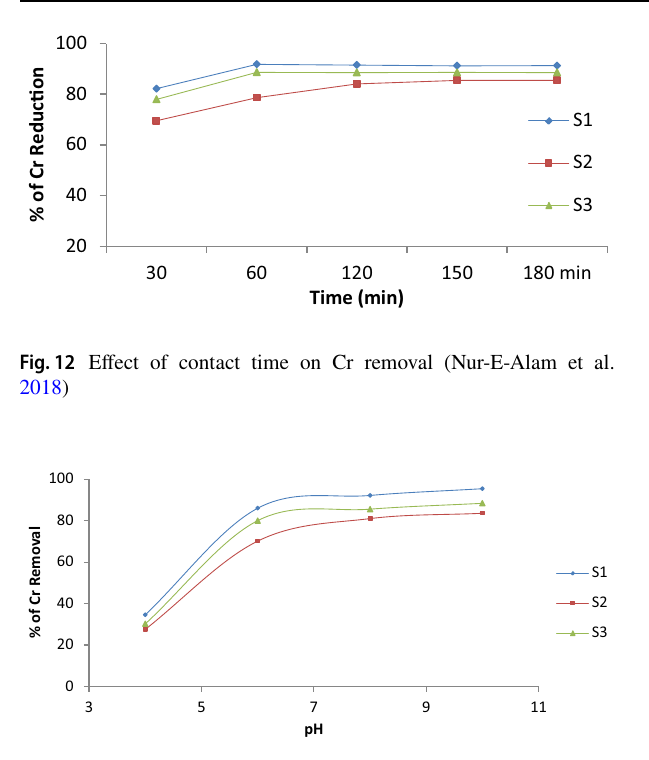
Fig. 13 Effect of pH on Cr removal (Nur-E-Alam et al. 2018)